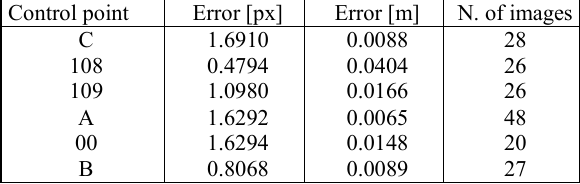
Table 1: Square Mean Error of control points